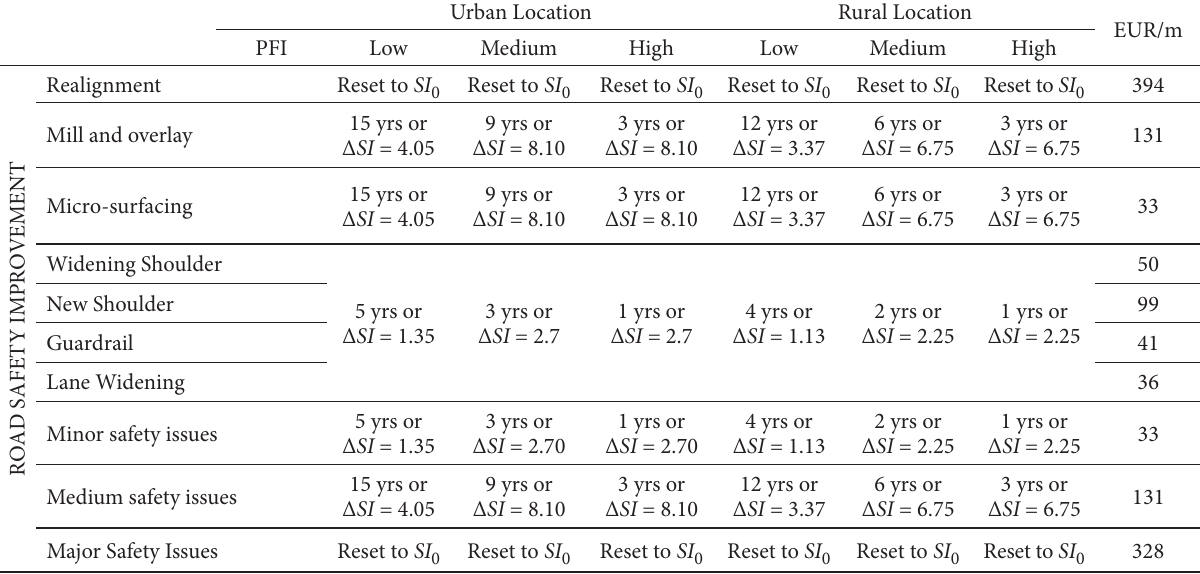
table 1. Treatment effectiveness (Gain in years or in Safety Index) and cost in EUR/m